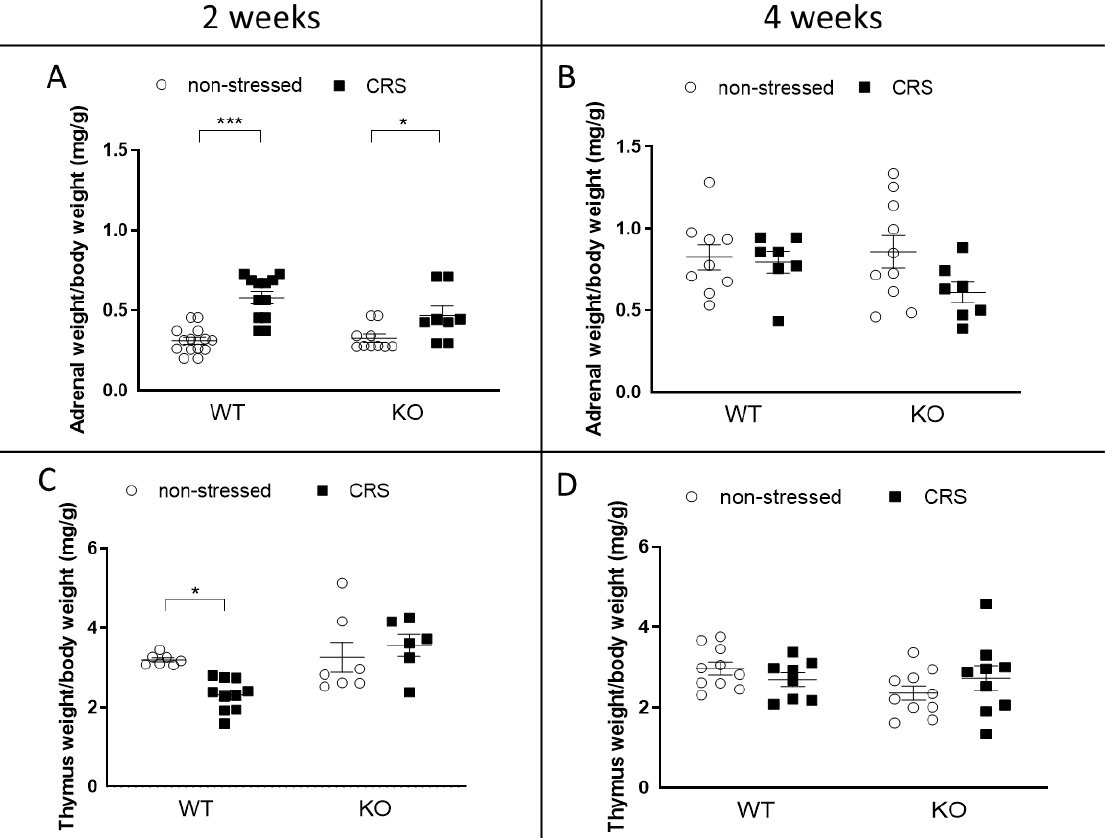
Figure 4. Effects of chronic restraint stress (CRS) on depression-like behavior in wild-type (WT) and Interleukine-1 knock-out (KO) female animals. Tail suspension test (TST) shows time spent